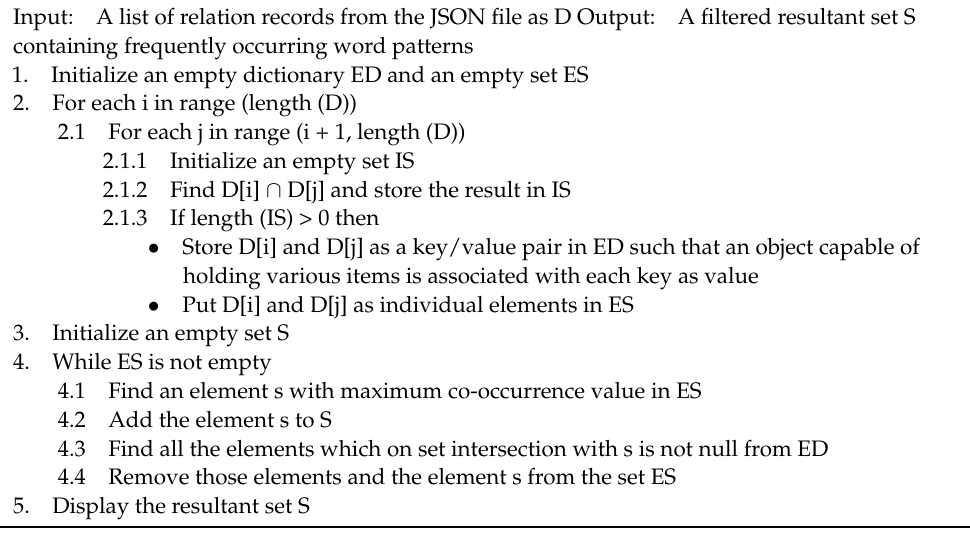
Algorithm 4 TREASURE Relation Records Filtration based on Maximum Co-occurrence Value and Set